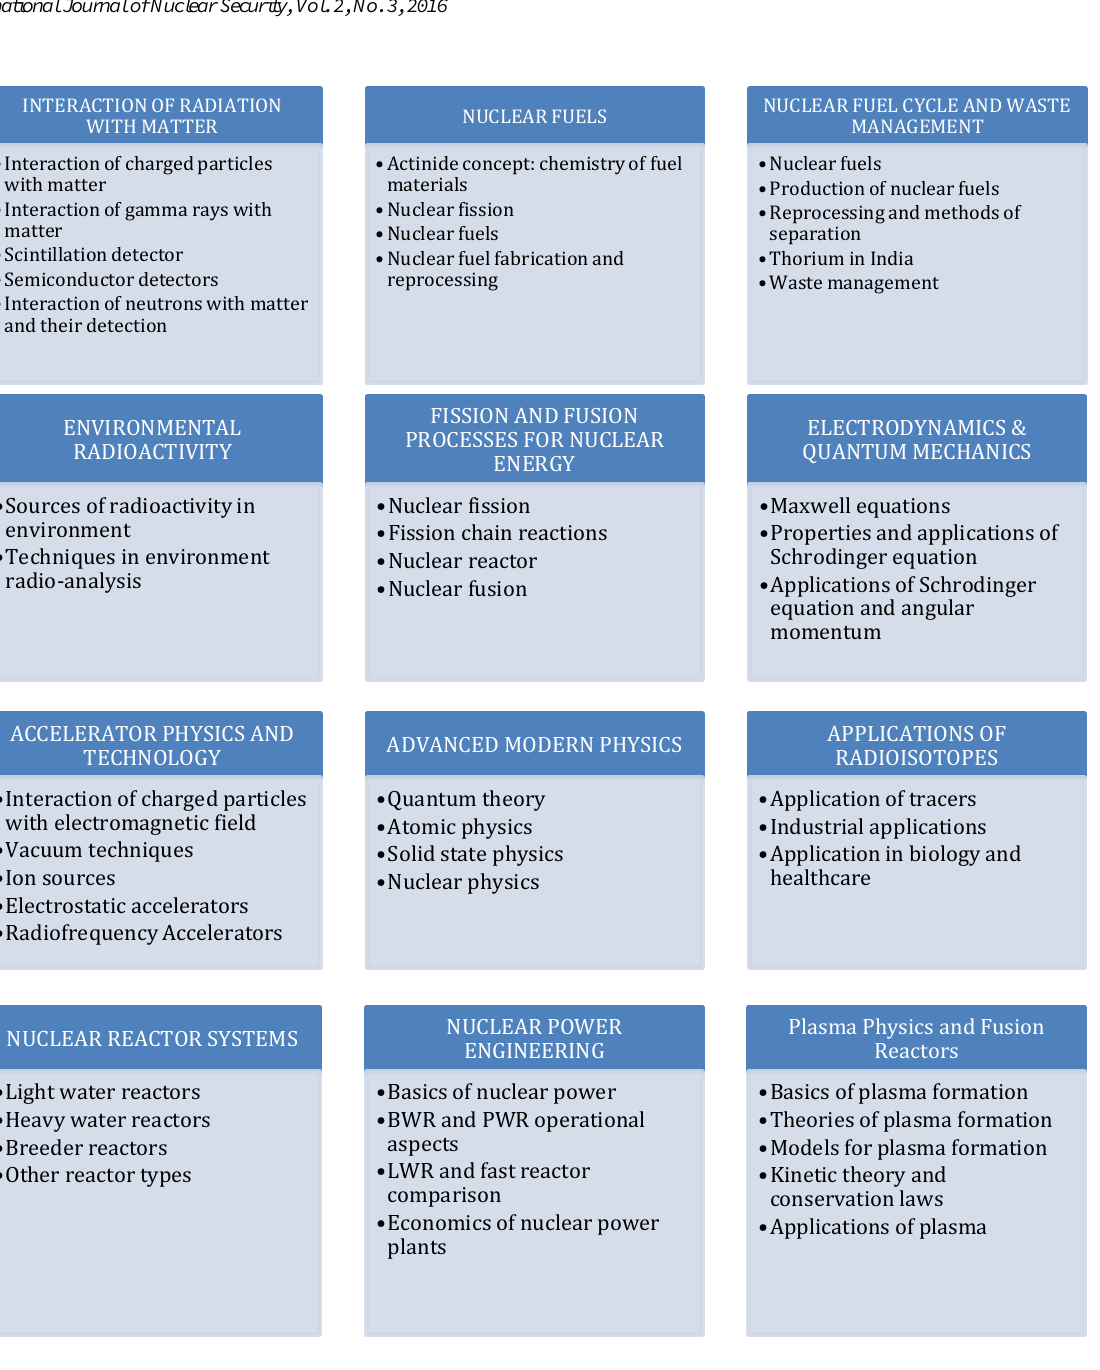
Figure 3. Existing Course Curriculum at the